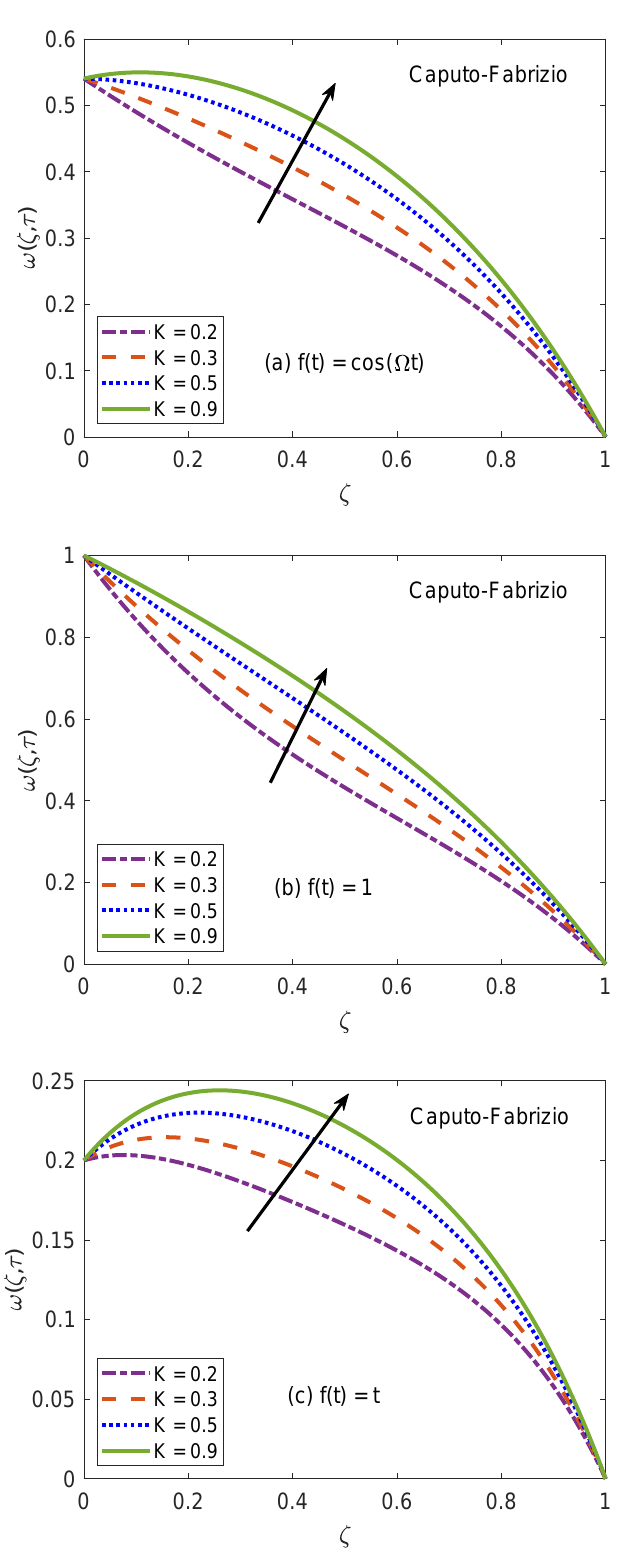
Figure 15. Velocity patterns of CF model for variation of K